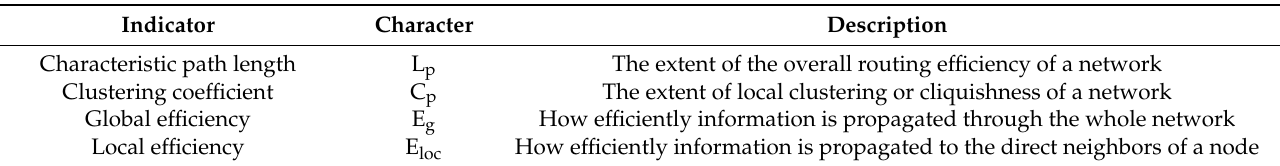
Table 1. Brief descriptions of complex network indicators in this